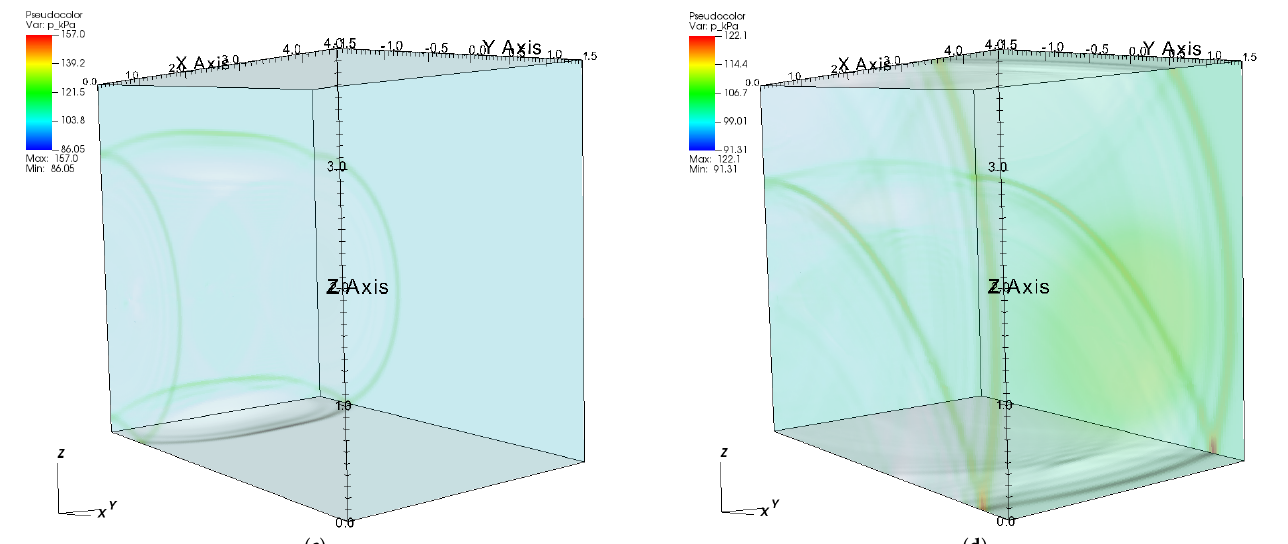
Figure 5. Snapshots of the pressure wave from explosion of a detonation cord ( a ) 0.27 ms, ( b ) 0.7 ms, ( c ) 4.6 ms, and ( d ) 12 ms after programmed